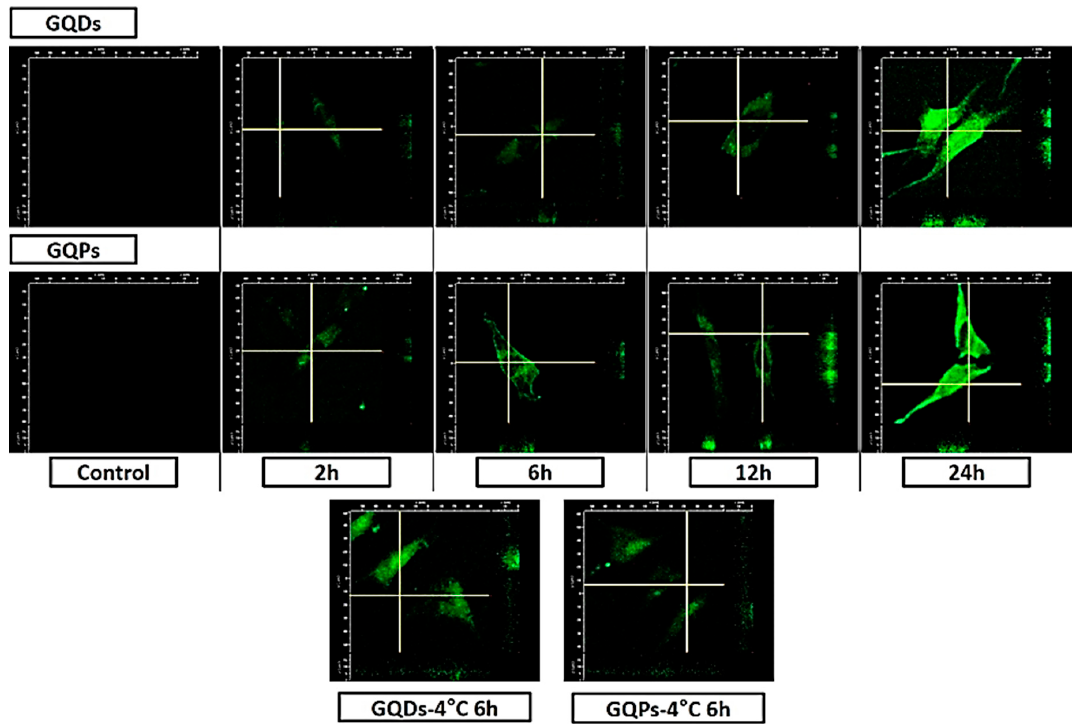
Figure 10. 3D reconstructed confocal images for analysis of cellular distribution of GQDs and GQPs in NHDF. The fluorescence emission was present only in cytoplasm except nucleus until 12 h. After 24 h, it was observed in the whole cell. The two images at the bottom of figure were the 3D reconstructed confocal images of blocking endocytosis at low temperature. X and Y -axis scale are 100 µ m and the yellow line indicates the cross-section of confocal image.